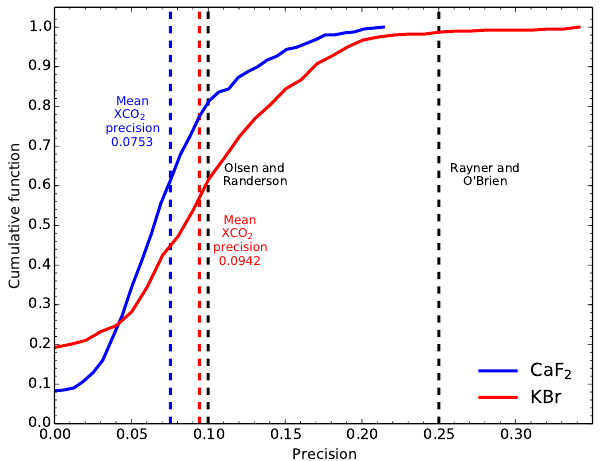
precision for both beam Figure 6. Hourly means of Altzomoni X CO 2 points) and Mauna Loa Observatory in situ CO 2 (MLO, green